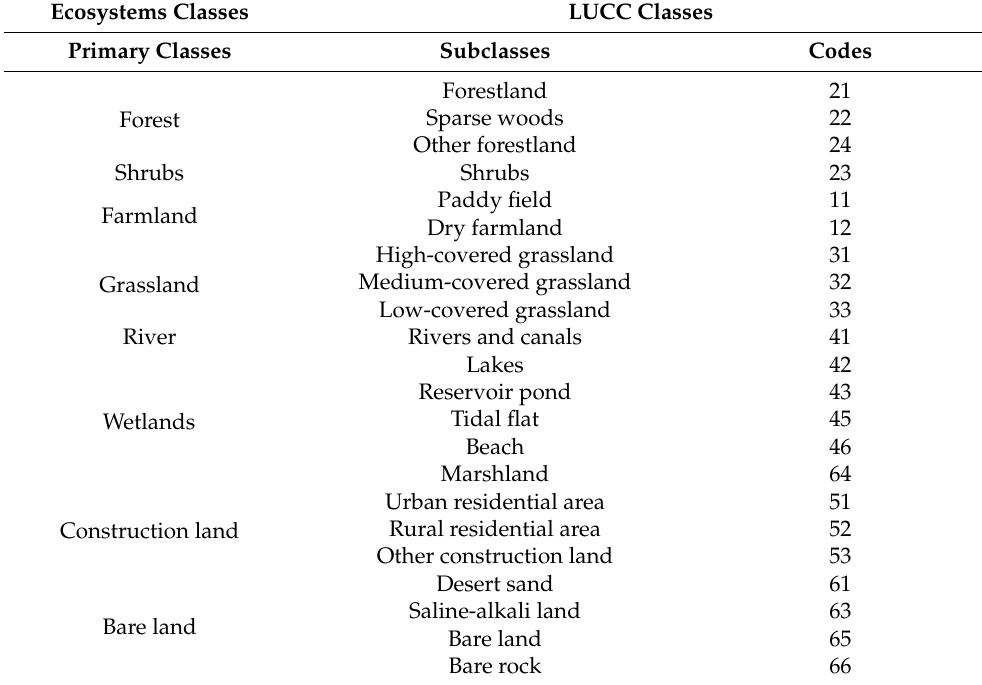
Table 1. Ecosystem classification